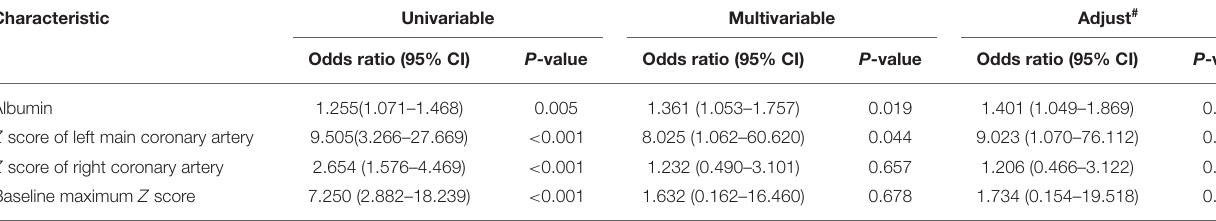
TABLE 5 | Results of logistic regression analyses of coronary artery aneurysm. Characteristic